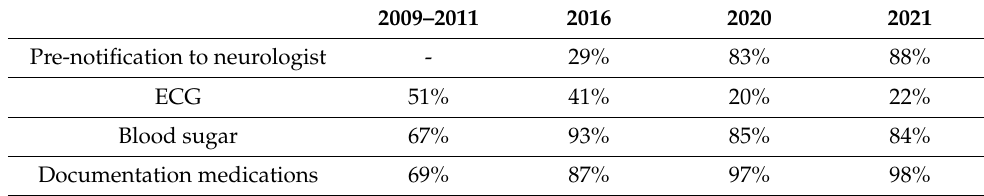
Table 1. Onsite activities of EMS from 2009 to 2021.